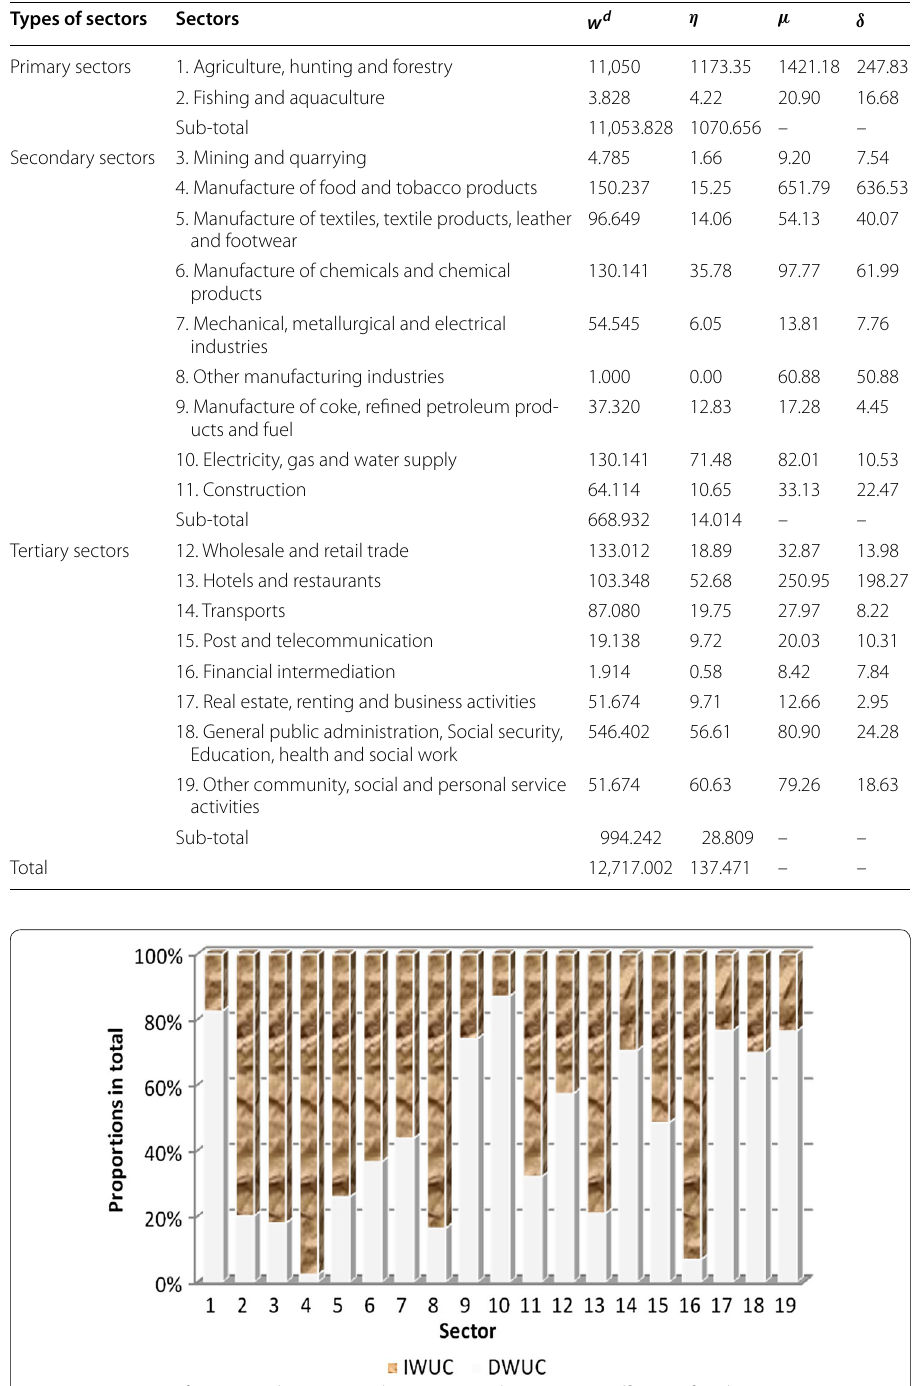
Table 2 Sectoral direct water use (10 6 m 3 ) and water use coefficients (m 3 /10 4 Dirham) Types of